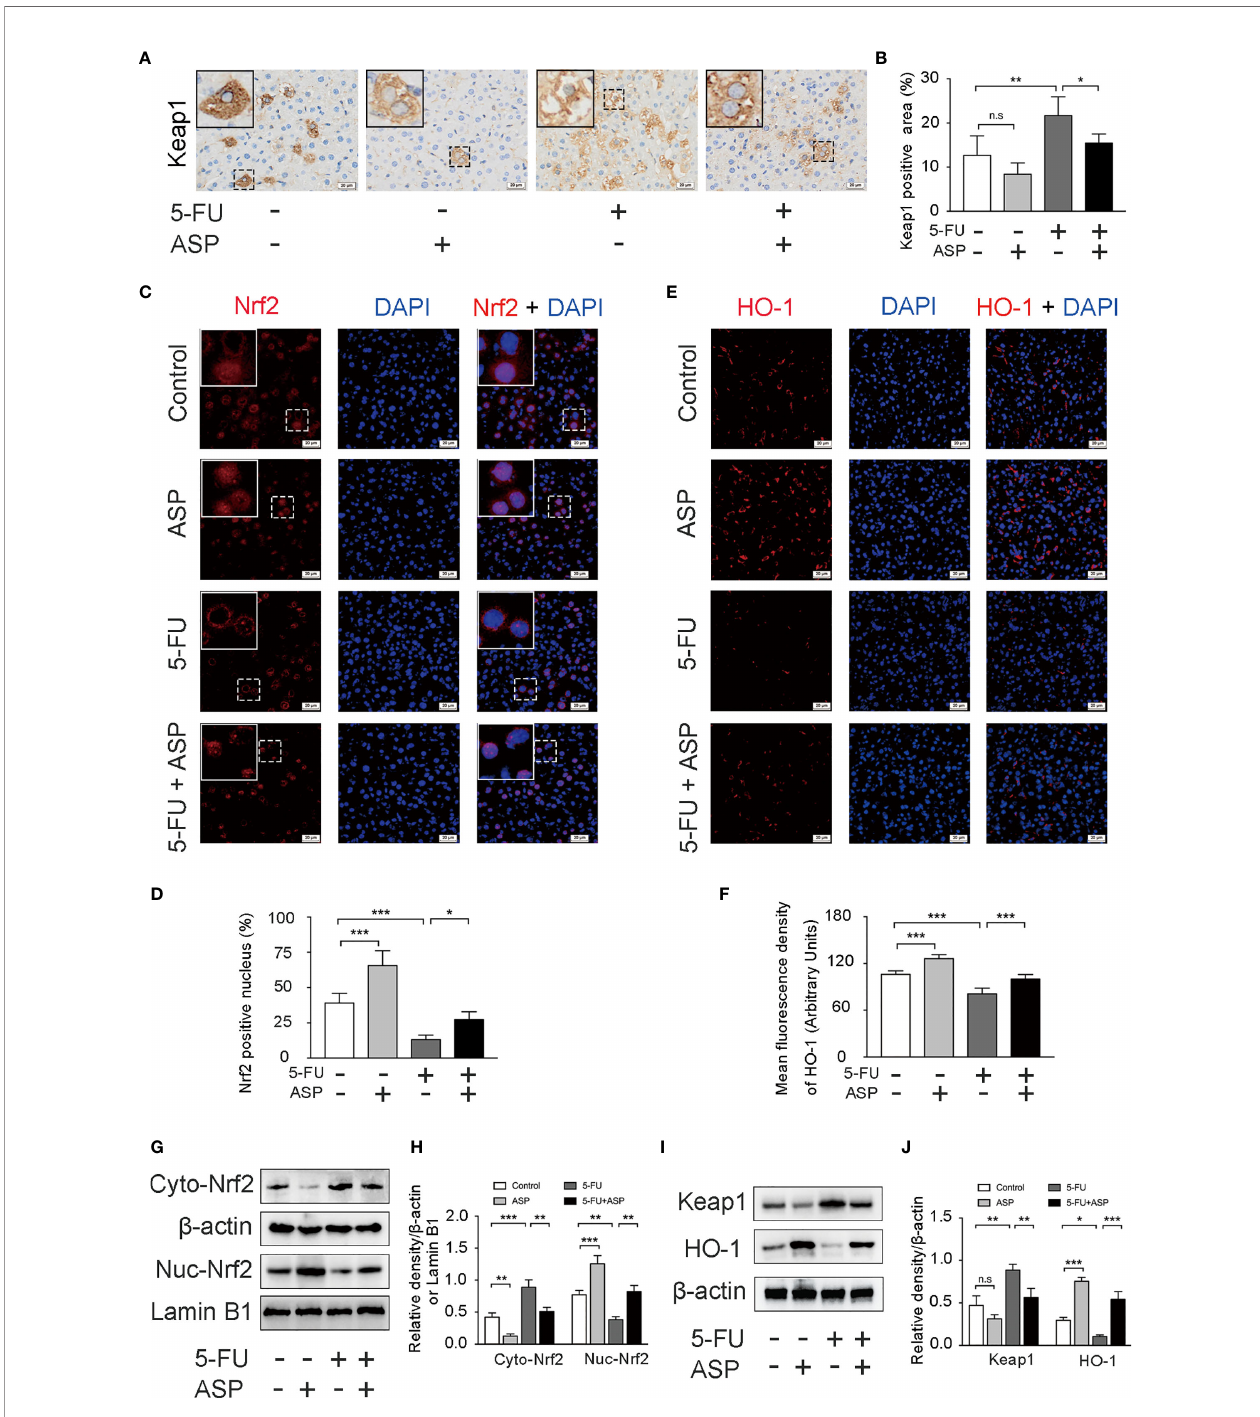
FIGURE 5 | ASP rescued the inhibition of the Keap1- Nrf2 pathway caused by 5-FU in vivo. (A) Immunohistochemistry was performed to detect the expression of Keap1 (magni fi cation, × 400, scale bar, 20 m m). (B) A semiquantitative analysis of the ratio of Keap1-positive staining to the total fi eld. (C) The nuclear translocation of Nrf2 was detected by immuno fl uorescence (IF) method, with Nrf2 antibody (red) and DAPI staining of the nucleus (blue) (magni fi cation, × 400, scale bar, 20 m m). (D) Quantitative results of the percentage of Nrf2-positive nuclei in the livers. (E) The immuno fl uorescence results showed that ASP alleviated the inhibition of HO-1 activity caused by 5-FU in the livers of mice (magni fi cation, × 400, scale bar, 20 m m). (F) The mean fl uorescence intensity of HO-1 was quanti fi ed ( n = 6/group). (G – J) Western blot assay was used to detect the cytoplasmic and nuclear levels of Nrf2 and the protein expression levels of Keap1 and HO-1in mouse livers ( n = 3/group). The intensity of the bands was calculated using ImageJ software. b -actin and Lamin B1 (nuclear fraction) served as the internal control. * p < 0.05; ** p < 0.01; *** p < 0.001. n.s., not statistically signi fi